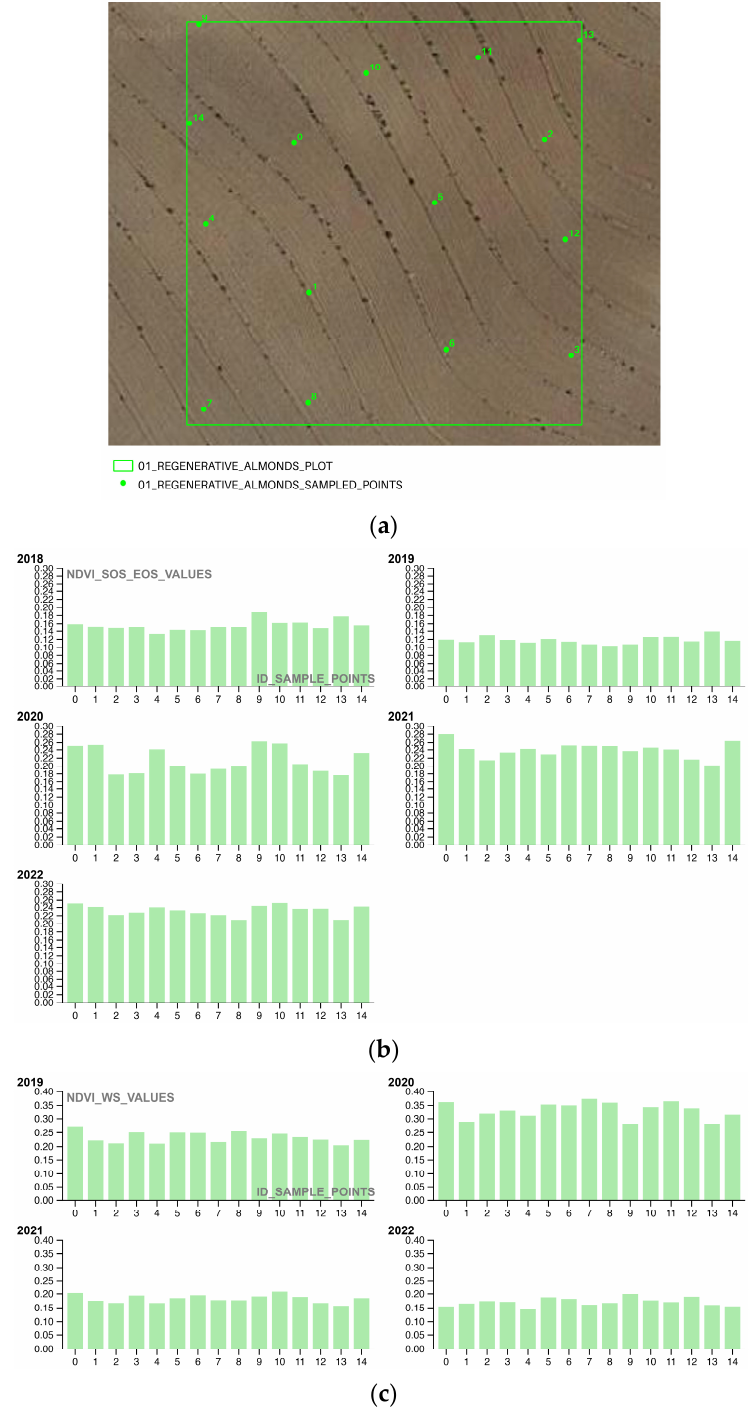
Figure 16. ( a ) The shapefile 01_REGENERATIVE_ALMONDS_PLOT.shp samples the COPERNICUS/S2_SR NDVI values of an exemplificative portion of the regenerative agriculture almonds planted with the keyline approach; ( b ) the COPERNICUS/S2_SR NDVI vegetation trends SOS-EOS phenological growth rate of the sample points (2018–2022) shows the trend in vegetation growth during the start of the growing season (SOS) and the end of the growing season (EOS) for the sampled regenerative agriculture almond plot; ( c ) the COPERNICUS/S2_SR NDVI vegetation trends WS phenological growth rate of the sample points (2018–2022) shows the trend in vegetation growth during the winter season (WS) for the sampled regenerative agriculture almond plot.